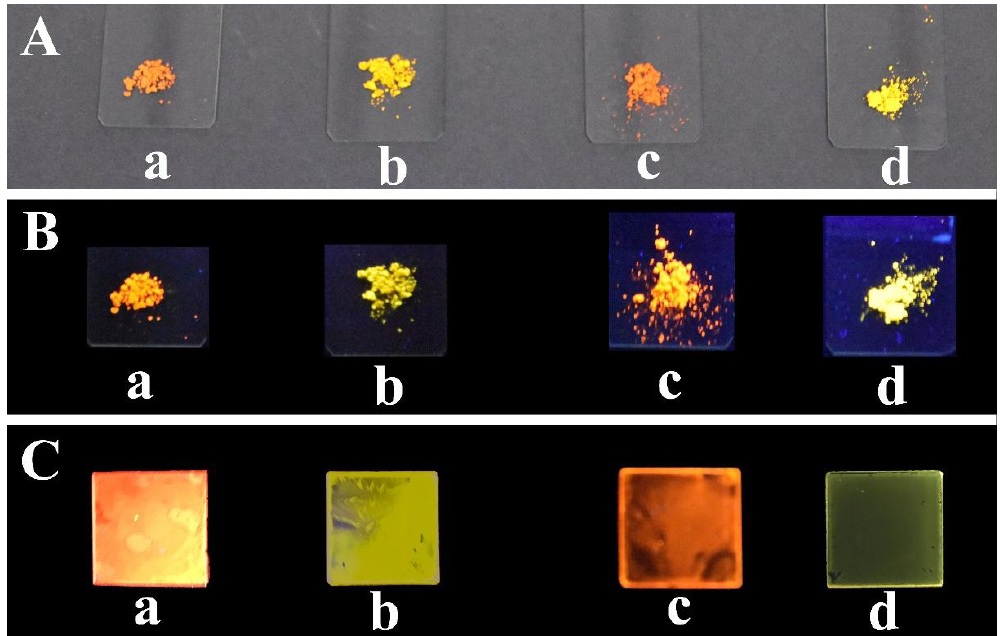
Figure 3. From left to right: P1b (a), P2b (b), co-P1b (c) and co-P2b (d) powder samples in natural light ( A ) and under 365 nm UV lamp ( B ). The correspondent cross-linked samples obtained by in situ deposition on quartz slides ( C ) under a 365 nm UV lamp.